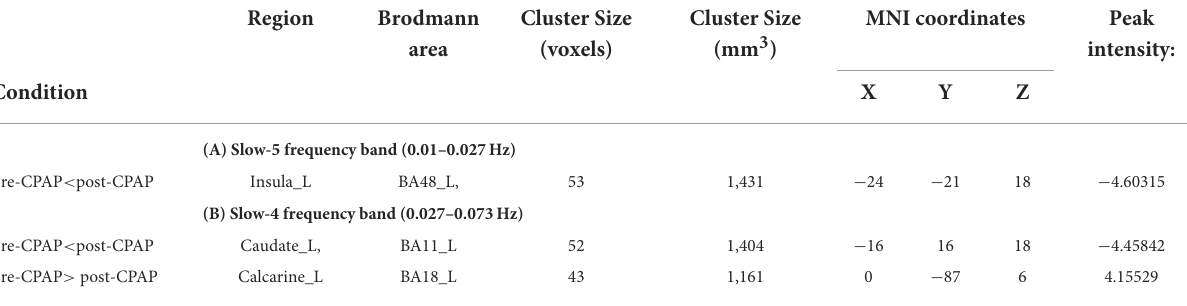
TABLE 3 The differences of ALFF in each frequency band between the pre-CPAP and post-CPAP group.